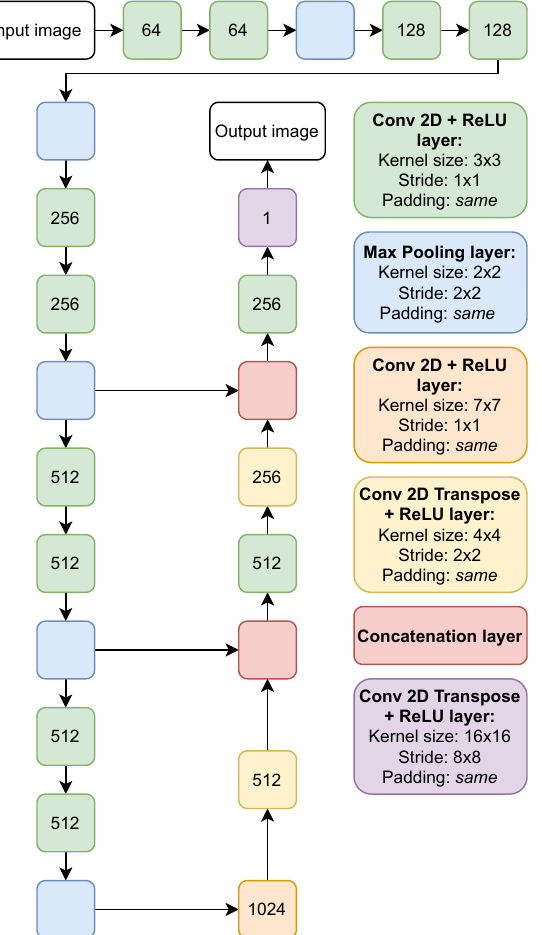
Figure 11. In-detail structure of the full architecture by Frizzi et al. [36] with the mentioned consider- ations. The numbers inside some of the blocks represent the number of filters per